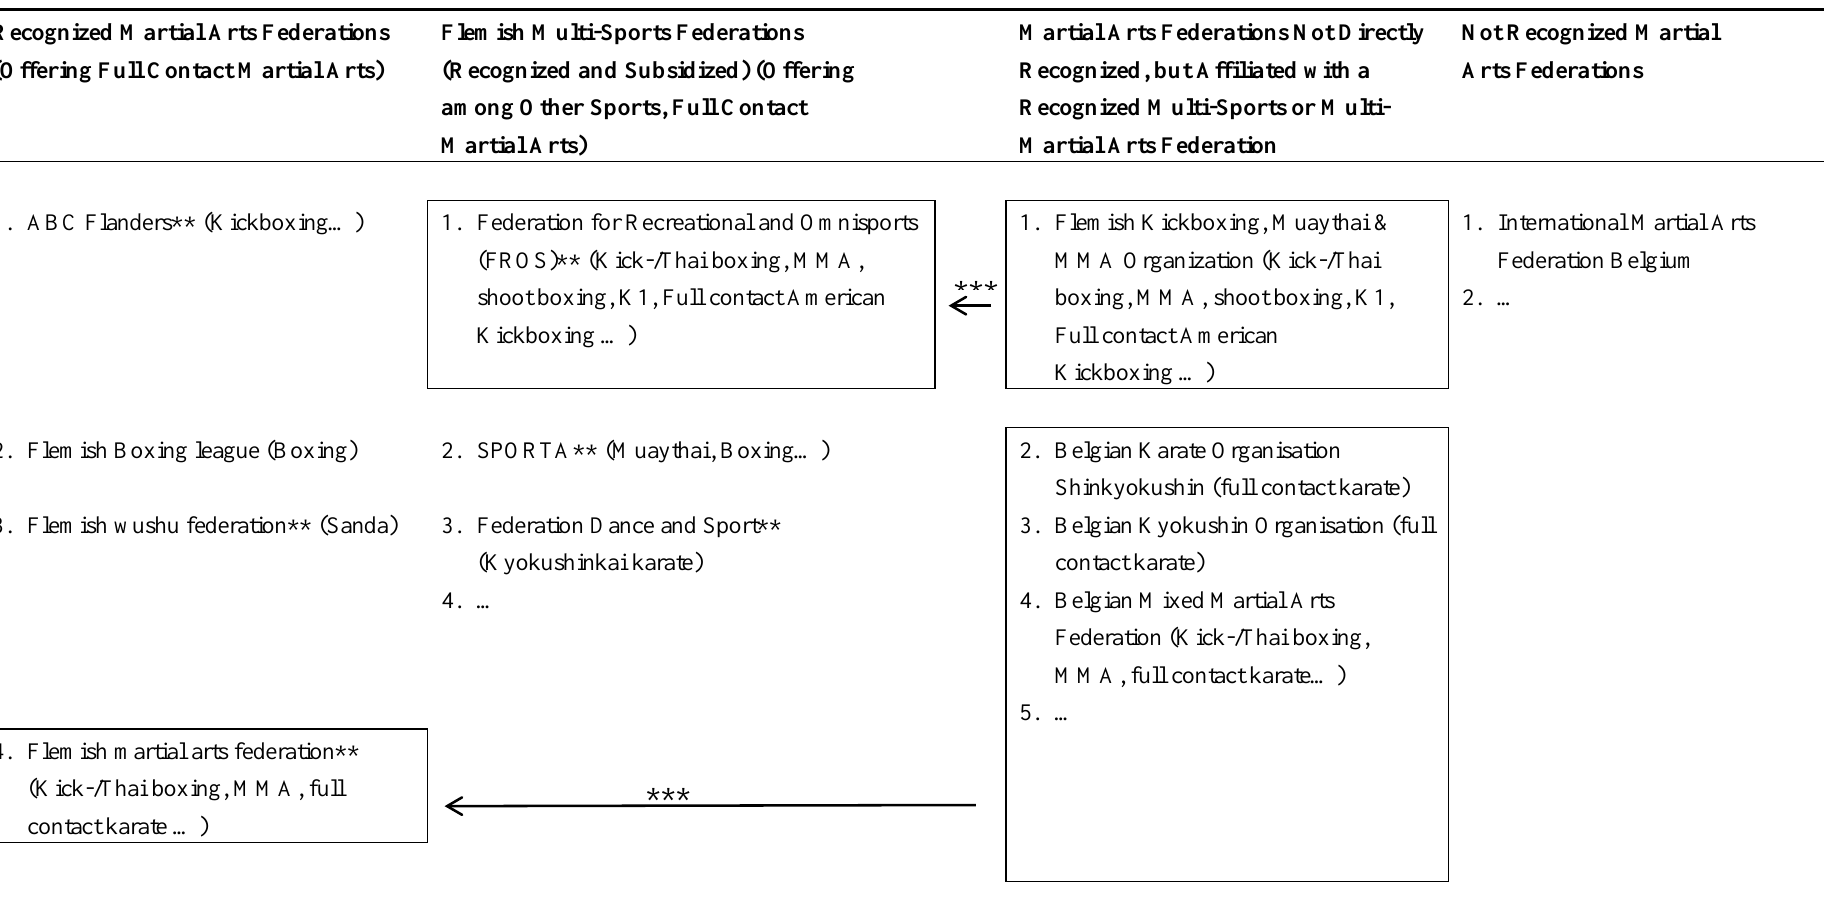
Table 1. Overview of Flemish federations offering full contact martial arts (boxing, kick-/Thaiboxing, Mixed Martial arts (MMA), cage fighting, K1, full contact karate and sanda).